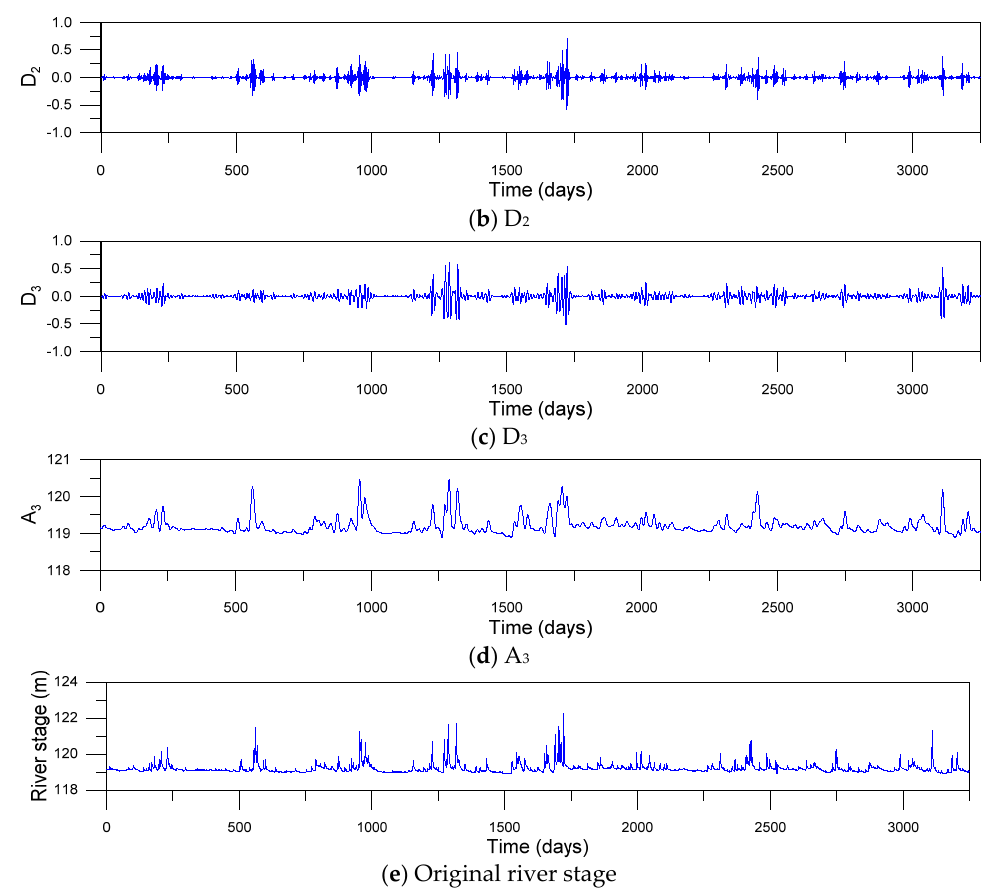
Figure 8. Sub-time series ( a – d ) decomposed by MODWT and original river stage time series ( e ) at the Songcheon gauging station.